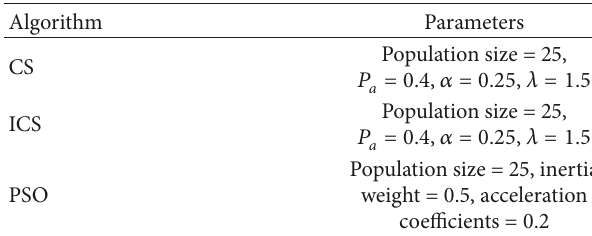
Table 2: The initial parameters of the three algorithms.